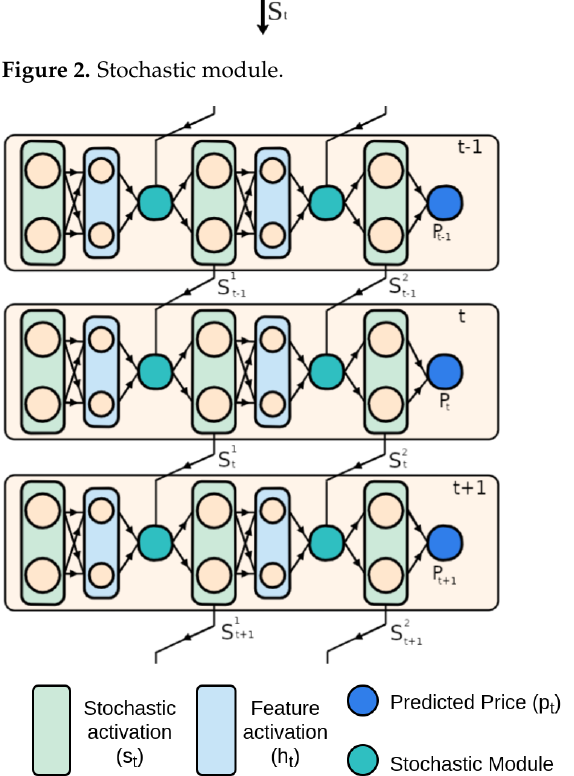
Figure 3. Unrolled architecture of stochastic neural network over consecutive timesteps. Algorithm 1 describes the integration of the stochastic module with a multi-layer perceptron where input features X t at time t is passed to the network. A reaction vector is calculated from values computed from the previous time step at every